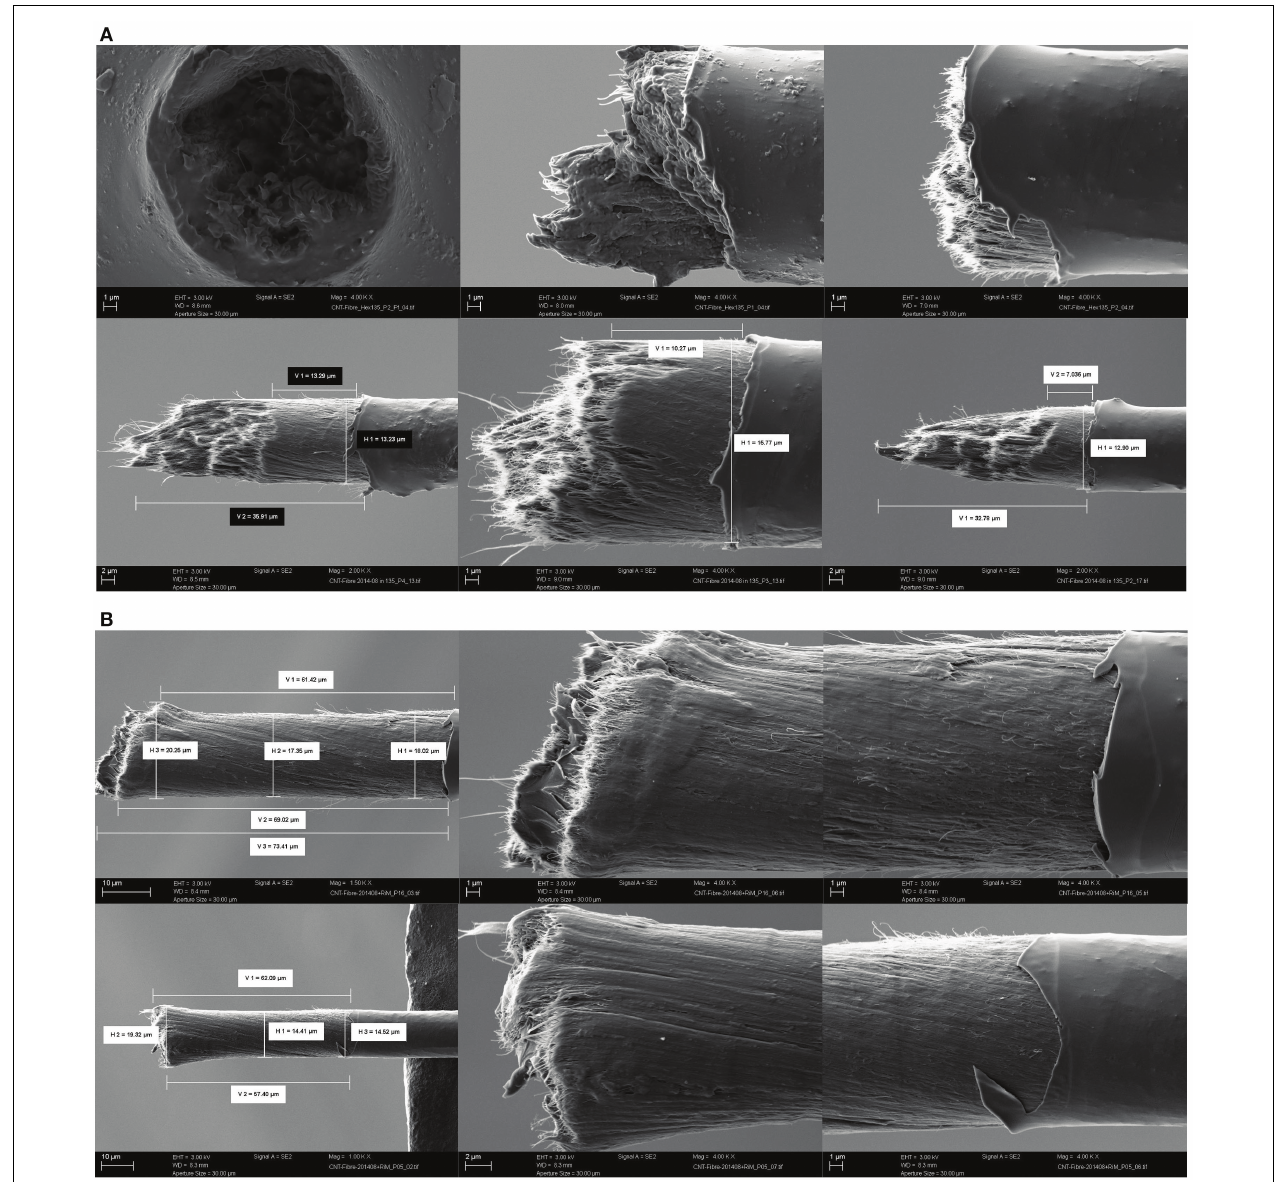
FIGURE 6 | SEM images of fracture surfaces after pulling untreated (A) and coated with RIM 135 resin (B) CNT fibers out of the epoxy matrix .